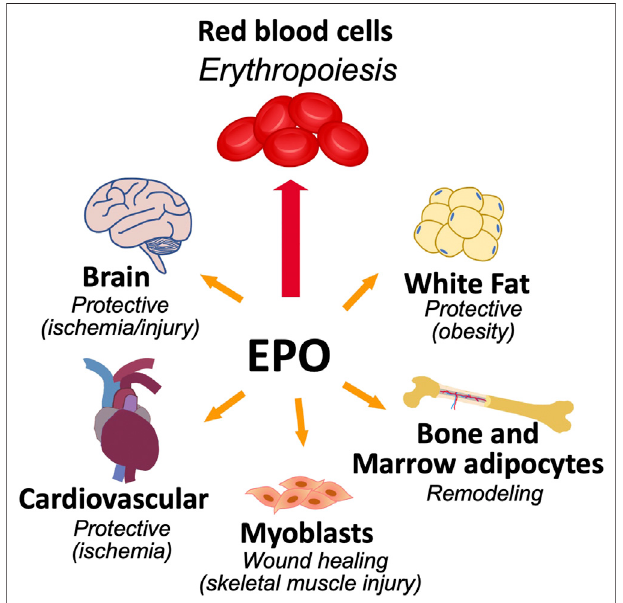
FIGURE 1 | Erythropoietin activity in erythroid and select non- hematopoietic tissues. The primary function of EPO is to regulate the production of red blood cells from erythroid progenitor cells that express high level of EPOR. EPOR expression in non-hematopoietic tissue provides for EPO response that includes brain for neuroprotection and metabolic response, cardiovascular system for cardioprotection and endothelial regulation of vascular tone and oxygen delivery, skeletal muscle maintenance and wound healing, bone remodeling, and metabolic response in white adipose tissue including sex-dimorphic regulation of fat mass and in fl ammation associated with diet induced obesity.